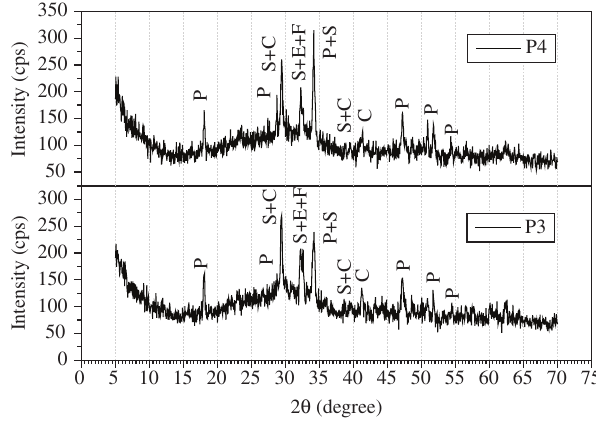
Figure 9. XRD patterns of the P3 and P4 pastes after 28 days of hydration. P. portlandite (Ca(OH) ); CC. Calcium carbonate (CaCO 2 (Ca [Al(OH) ] (SO ) .26H O); S. silicates; F. ferrite. 6 6 2 4 3 2